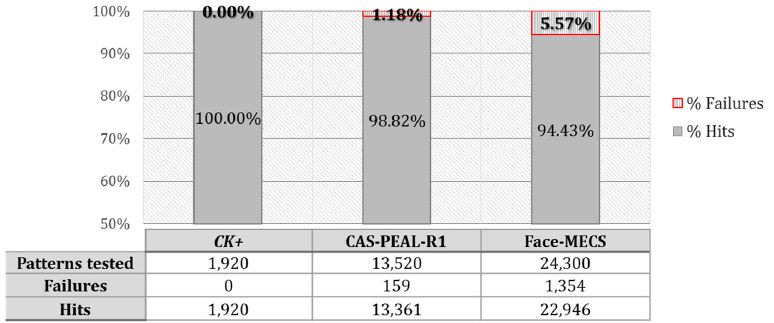
Figure 11. Results obtained by applying the Haar-like features (HLF) in the proposed databases.